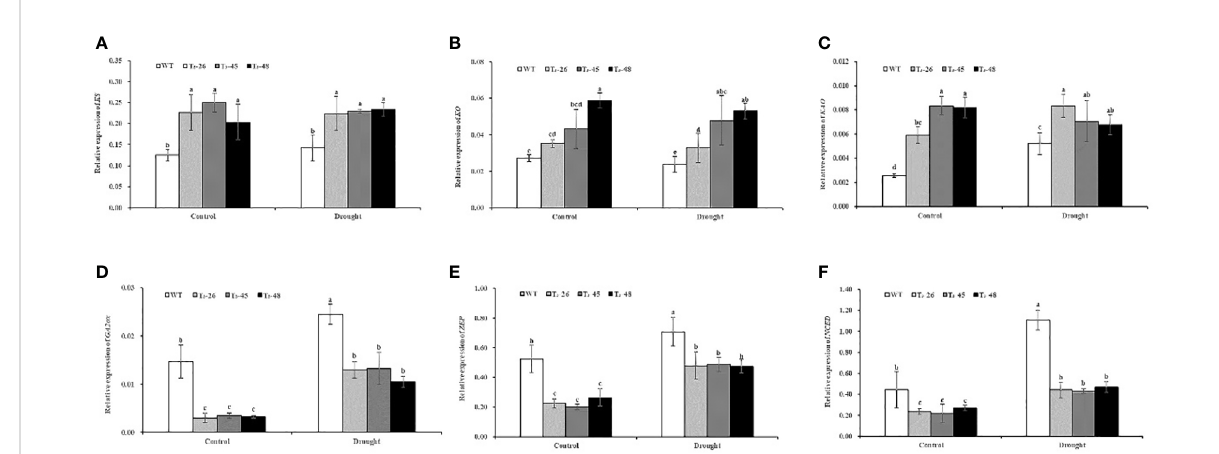
FIGURE 5 (A) The relative expression of ent- acid synthase gene KS. (B) The relative expression of ent- acid oxidase gene KO. (C) The relative expression of ent-acid oxidase gene KAO. (D) The relative expression of GA2-oxidase gene GA2ox. (E) The relative expression of zeaxanthin epoxidase gene ZEP. (F) The relative expression of 9-cis epoxycarotenoid dioxygenase gene NCED. Error bars represent means ± SD. Statistical analysis was performed using the ANOVA test (p< 0.05) and signi fi cant differences are indicated by different